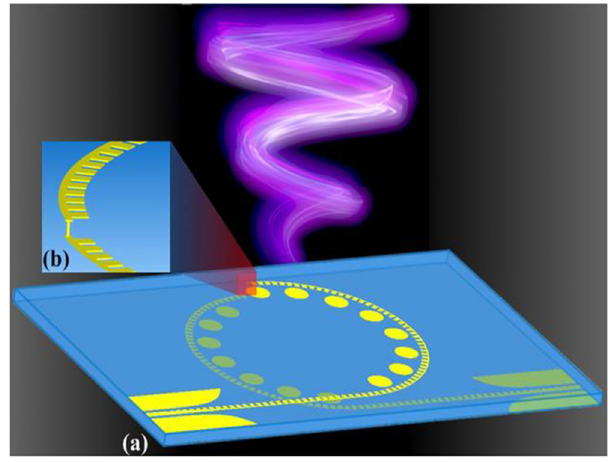
Fig. 6. A microwave vortex-beam emitter based on SSPPs [29].